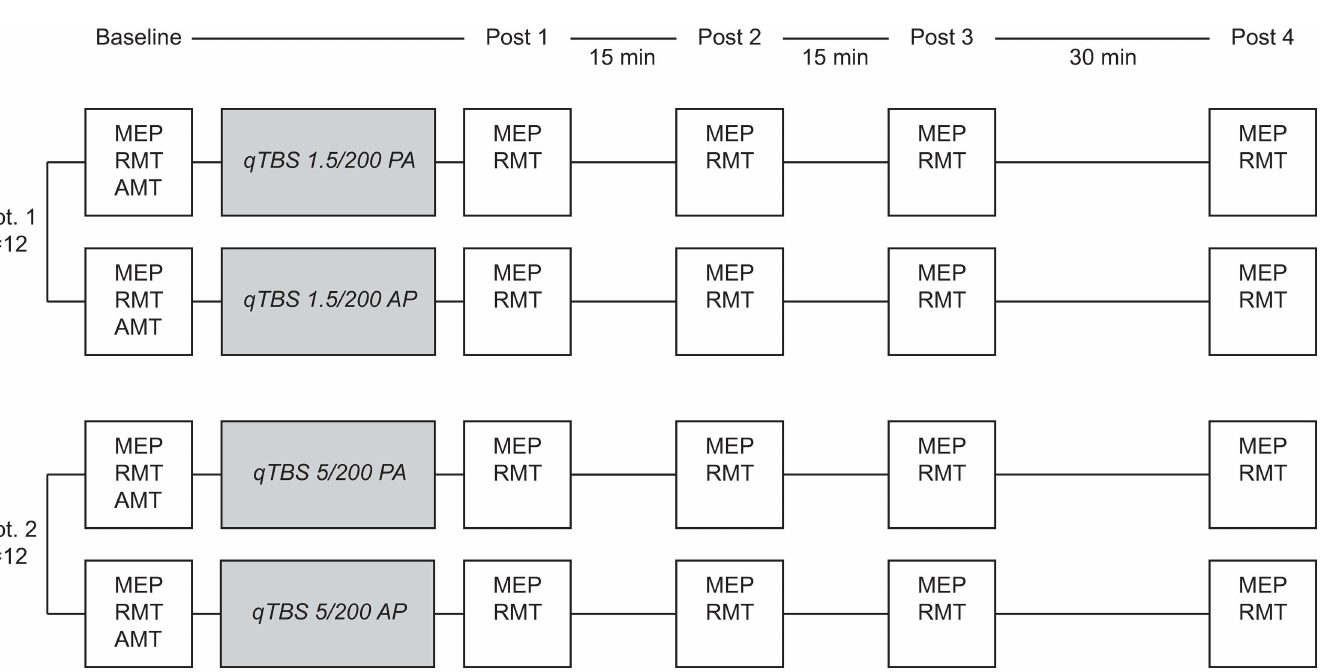
Fig 1. Experimental procedures, timeline of experiments and number of participants for each experiment. We performed two sets of experiments. In experiment 1, the interstimulus interval (ISI) of each pulse was set to 1.5 ms (666 Hz) to test I-wave frequencydependentpatterns of qTBS. In experiment 2, the ISI was set to 5 ms and consequently suggested to be outside I-wave periodicity. In all experiments, the current flow in the brain was reversed from PA to AP. MEP: motor evoked potential, RMT: resting motor threshold, AMT: active motor